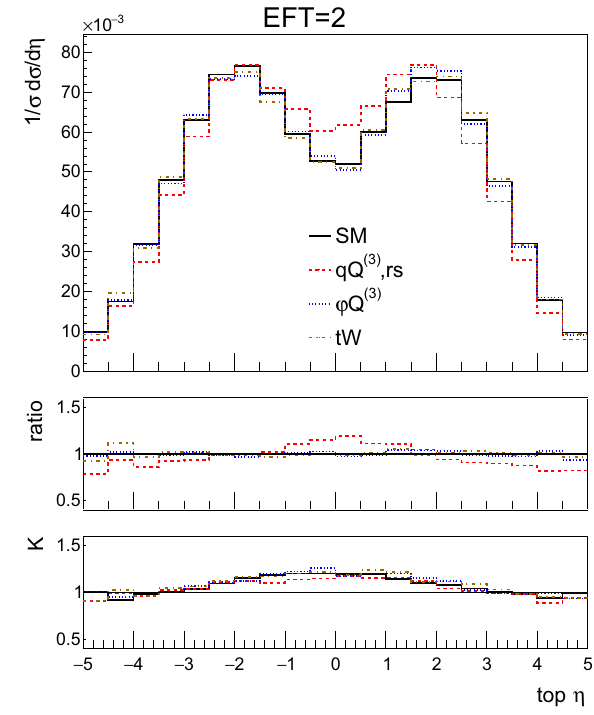
Fig. 11 The NLO distributions of the reconstructed top transverse momentum (left) and rapidity (right) for the SM and the three effec- tive operators of interest for the couplings values of Table 2. We quote